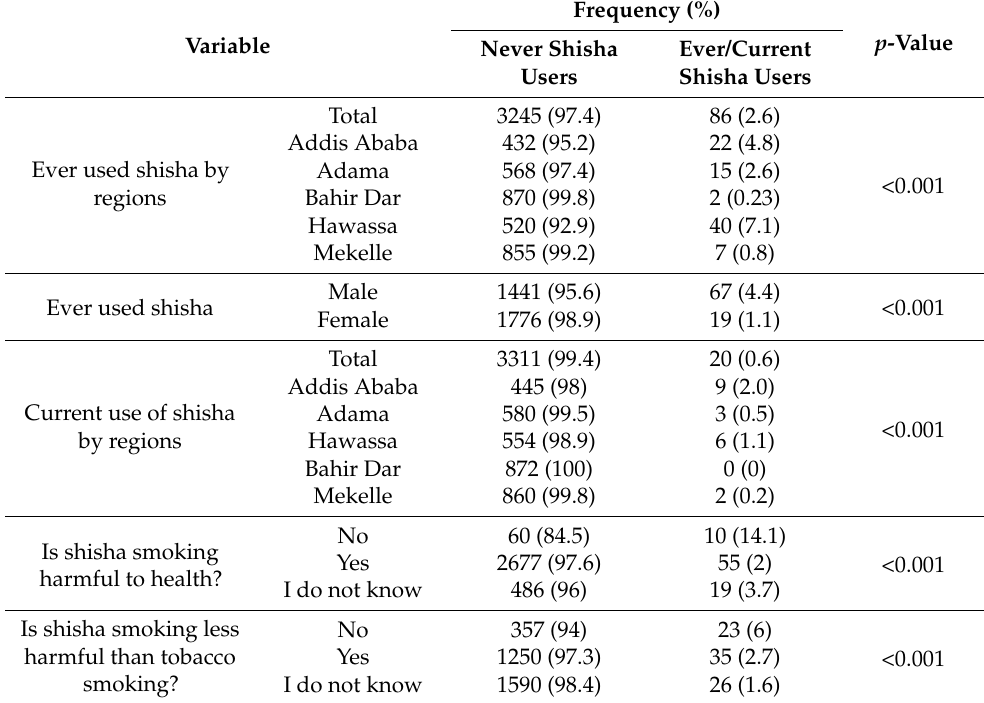
Table 2. Prevalence and perception about shisha smoking among high school students in